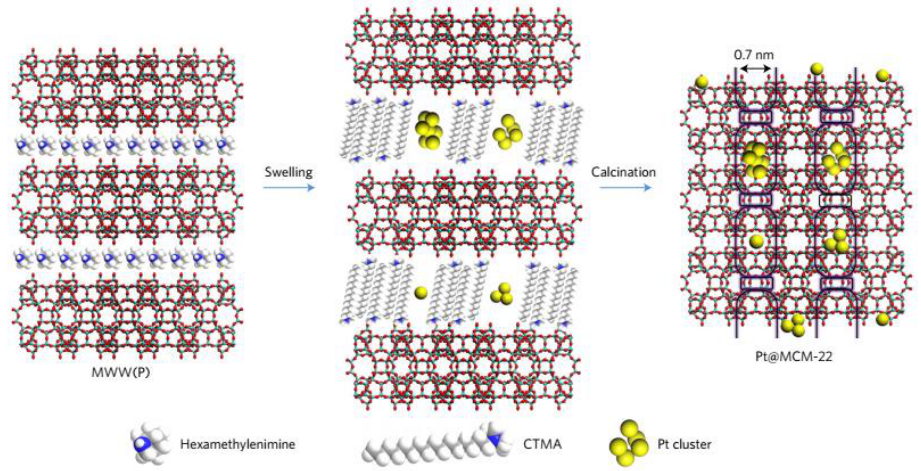
Figure 5. Scheme of confining platinum species in the MCM-22 structure by swelling the MWW precursor with surfactants and platinum species and a subsequent calcination. Reprinted with permission from Springer Nature, Reference [56].